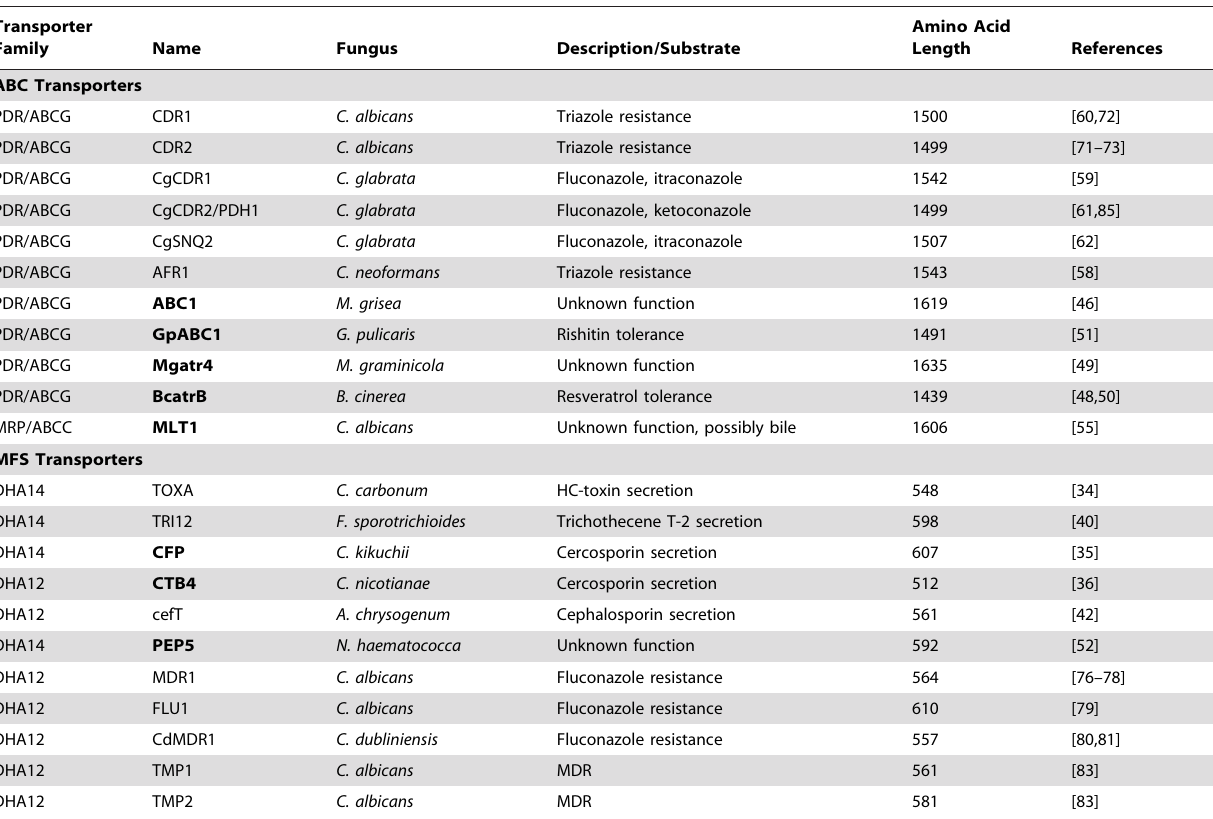
Table 1. Summary of Transporters Involved in Virulence or Toxin and Drug Efflux.